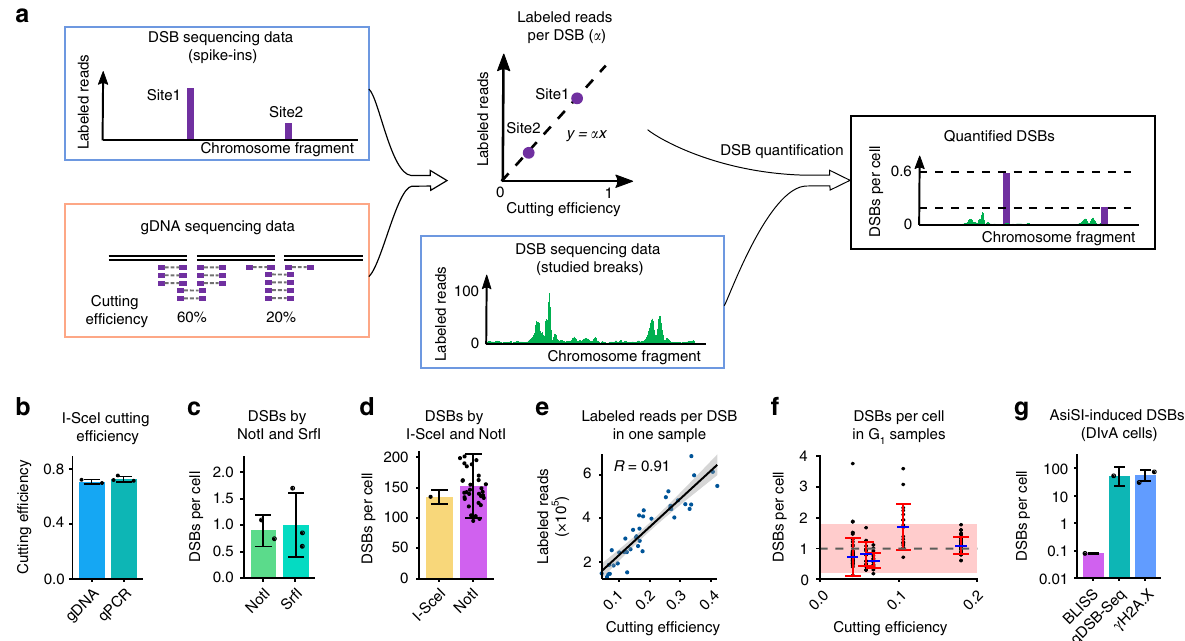
Fig. 2 qDSB-Seq computation and validation. a Computation of the labeled reads per DSB and DSBs per cell. The ratio of the labeled reads and cutting ef fi ciency at enzyme cutting sites was calculated and then used for DSB quanti fi cation in the studied genomic loci. b The estimation of I-SceI cutting ef fi ciency based on gDNA sequencing ( n = 2) and qPCR ( n = 3). c , d Dependence of qDSB-Seq quanti fi cation on the restriction enzyme used. For untreated WT G 1 -phase cells ( c ), DSBs were quanti fi ed using NotI and SrfI digestion in vitro, two and three biological replicates, respectively. For hydroxyurea (HU)- treated WT S-phase cells ( d ), DSBs were quanti fi ed by I-SceI digestion in vivo (SD was estimated as described in Methods) and NotI digestion in vitro ( n = 39, Methods). e Correlation between the number of labeled reads at cutting sites and their cutting ef fi ciencies in an untreated G 1 -phase sample, digested with NotI enzyme with an average cutting ef fi ciency of 18 %. R : Pearson ’ s correlation coef fi cient. The linear regression line with 95% con fi dence interval is plotted. f DSB numbers in fi ve untreated G 1 -phase cells. The dashed gray line and the pink-colored area are the mean value ( n = 5) and 95% con fi dence interval, respectively, for all the samples. DSBs per cell values in individual samples are denoted by blue dash, SD are denoted by red intervals ( n = 39, 17, 17, 18, 39 from left to right, Methods). g Quanti fi cation of AsiSI-induced DSBs in DIvA cells by BLISS (SD, Methods), qDSB-Seq (with BLESS labeling, SD as described in Methods), and counting γ H2A.X foci ( n = 2), logarithmic scale on the y axis was used. Mean and SD are shown in b and c . DSBs per cell values and SD were calculated as described in Methods in d , f , g . Individual data points are visualized as black dots ( b – d , f , g ). Source data